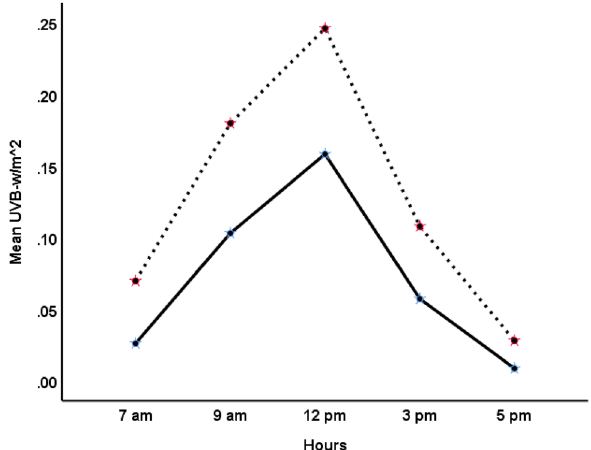
Figure 1. UVB intensity at earth’s surface at different hours in summer (March to September) and winter (October to February) months in Kuwait (Latitude range 28.30–30.00 N). Dotted lines represent summer months and solid line represents winter